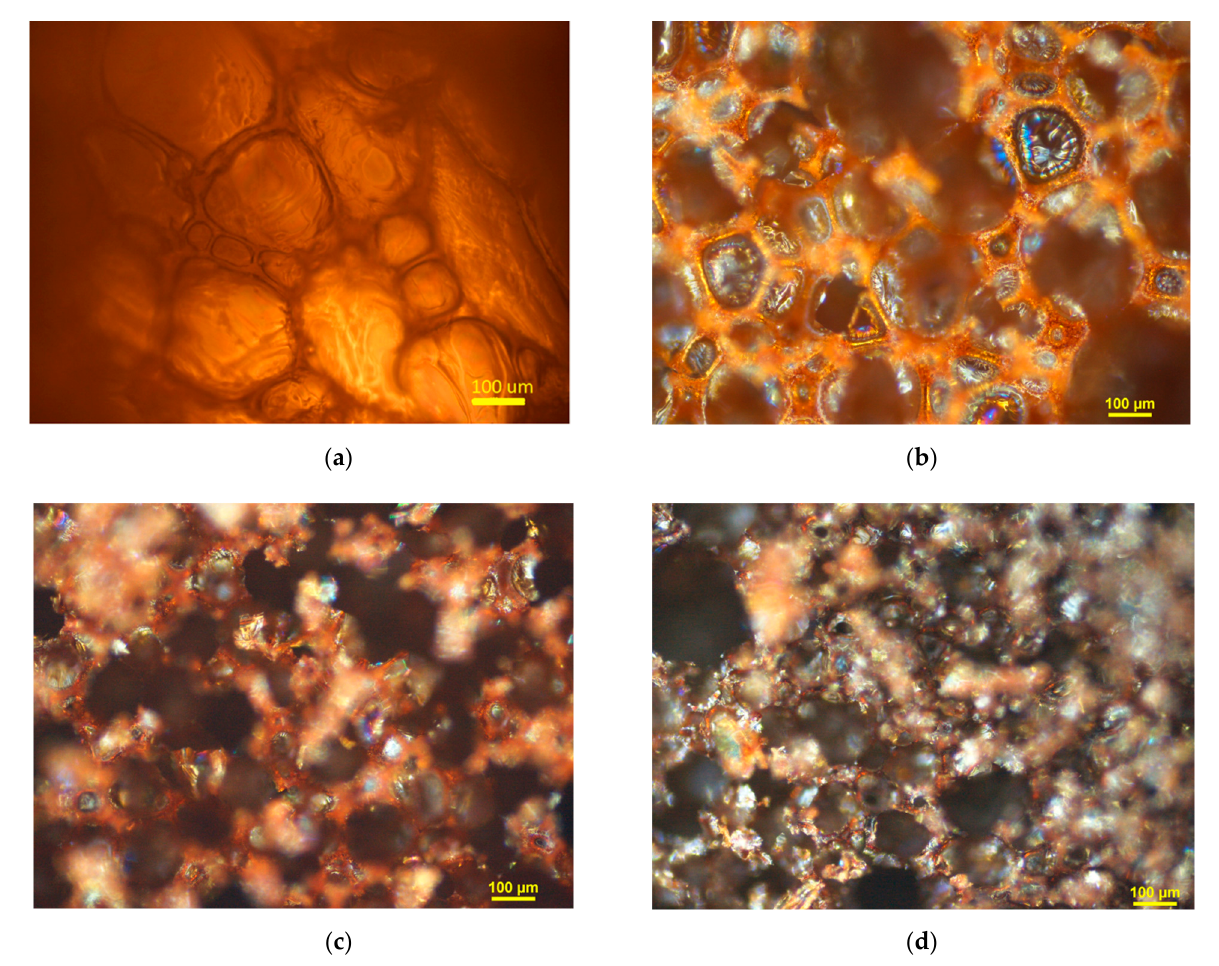
Figure 4. Optical microscopy of foam before heating ( a ) and after exposure in temperatures 150 °C ( b ), 175 °C ( c ), and 200 °C ( d ).